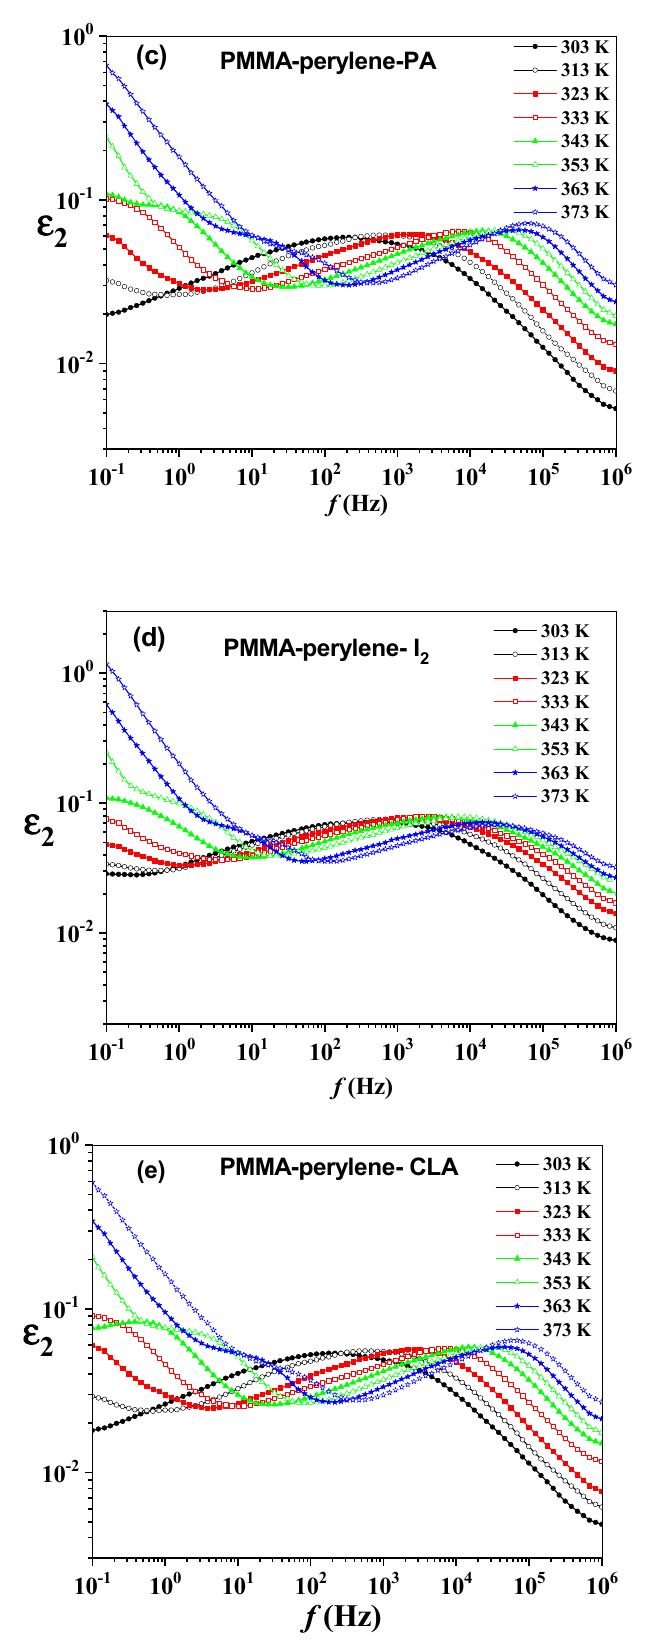
Figure 5. ( a – e ): The frequency dependence of the ε 2 of the synthesized polymeric sheets. The experimental relaxation behavior of the above results can be described by the empirical dispersion function reported by Havriliak–Negami (HN) [34,35].